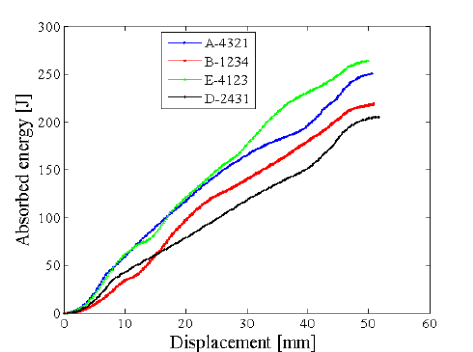
Fig. 4. Plots of absorbed energy versus displacement under impact loading ( v = 45